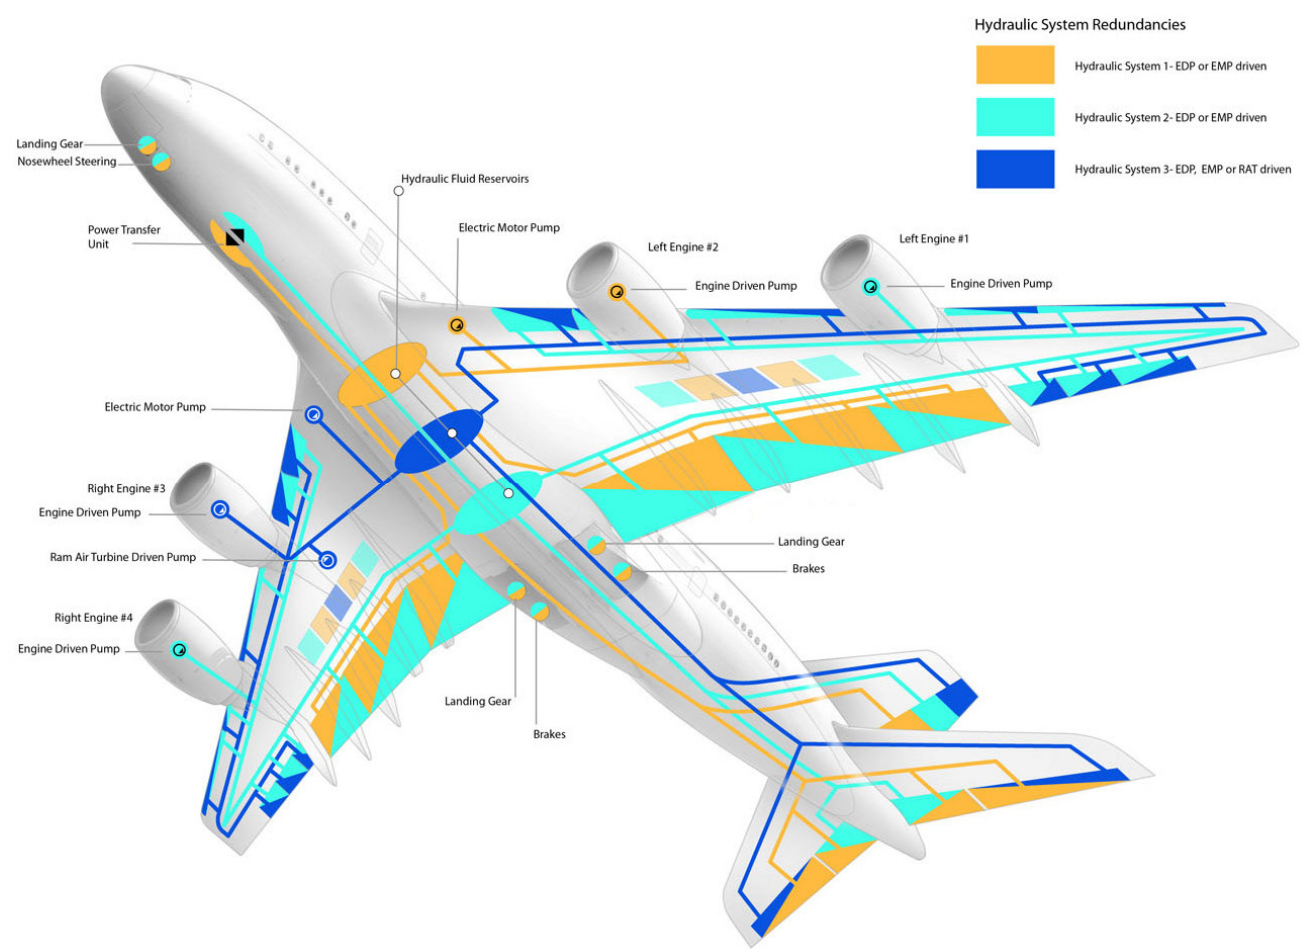
Figure 1. Structure of an aircraft hydraulic system.